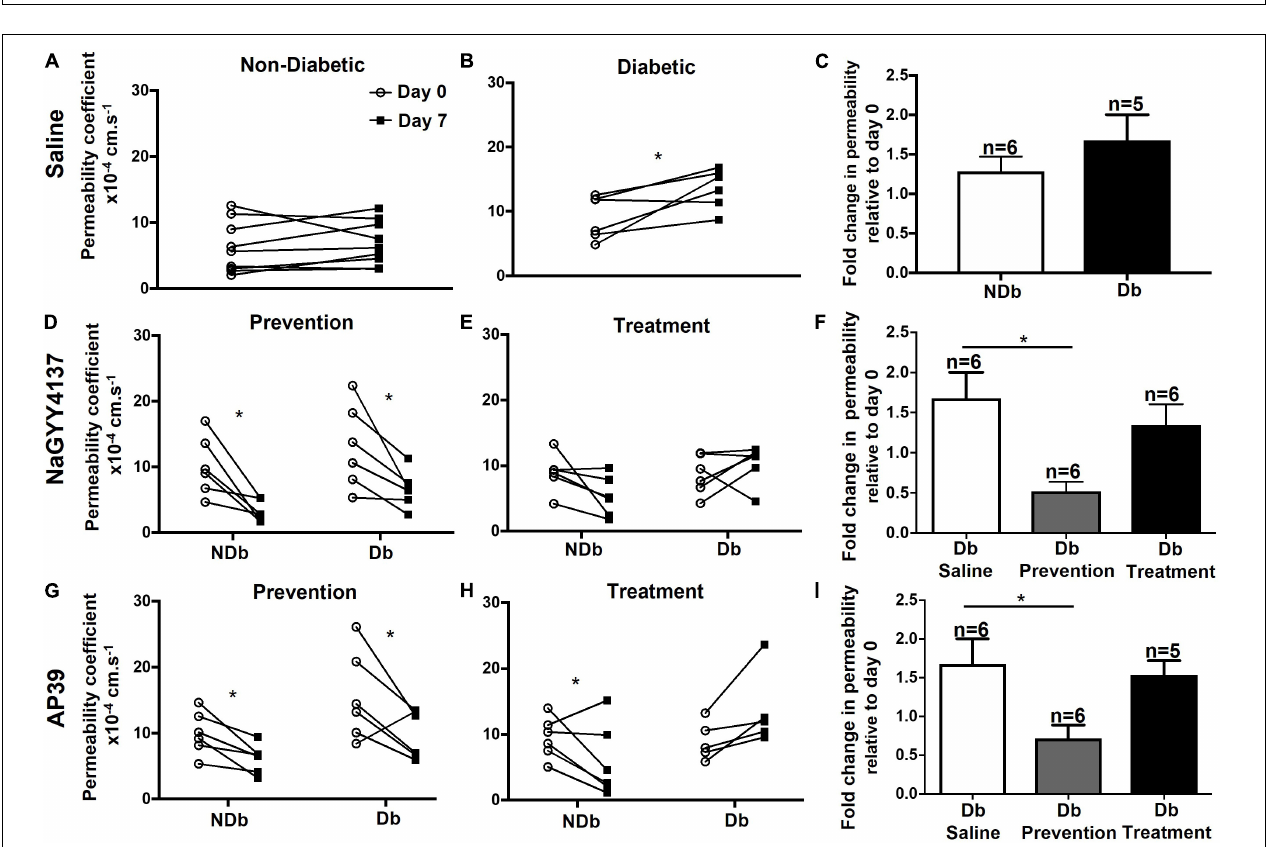
FIGURE 4 | Chemically induced diabetes significantly increased retinal vascular permeability in Norway Brown rats compared to non-diabetic controls. (A) Fundus fluorescein angiography measurements from a single rat carried out on day 0 (before STZ) and day 7 (1 week of STZ treatment). (B) Permeability was measured from control (blood glucose 7.99 ± 0.21 mmol/L), and (C) diabetic (blood glucose 29.75 ± 1.63 mmol/L) Norway Brown rats on days 0, 7, 14, 21, and 28. Apparent permeability was calculated as described in the methodology text and depicted in Figure 1 . Data including mean ± SEM. * p ≤ 0.001 vs. day 0, ** p ≤ 0.0001 vs. diabetic day 0. One-way ANOVA.